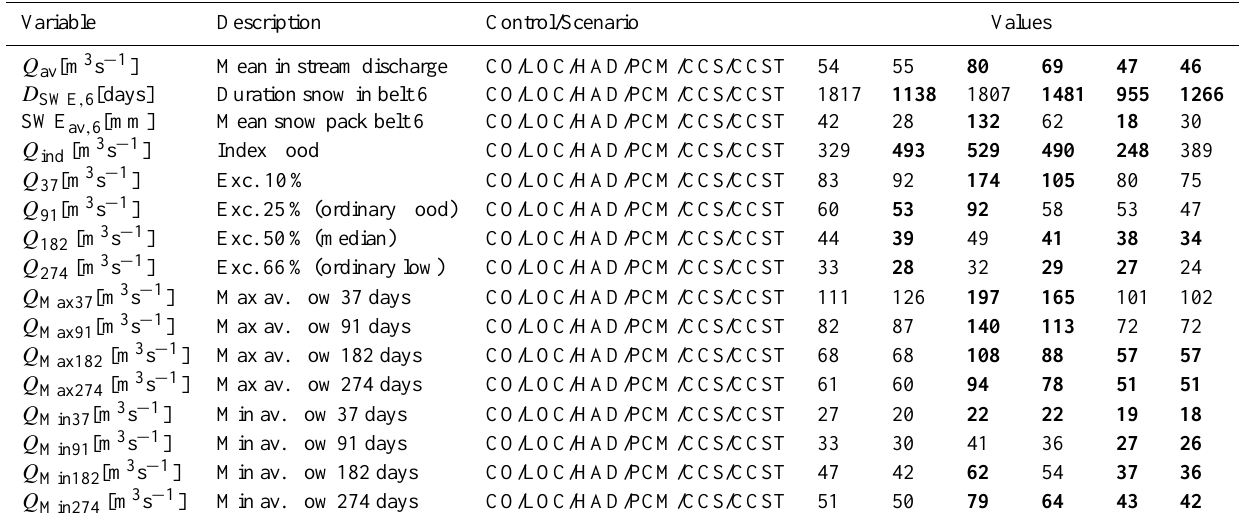
Table 5. Oglio at Sarnico. Relevant flow variables. Control run 1990–1999 and scenarios, 2045–2054. Bold font values are significantly ( α =5%) different from control run values, as explained in Sect.